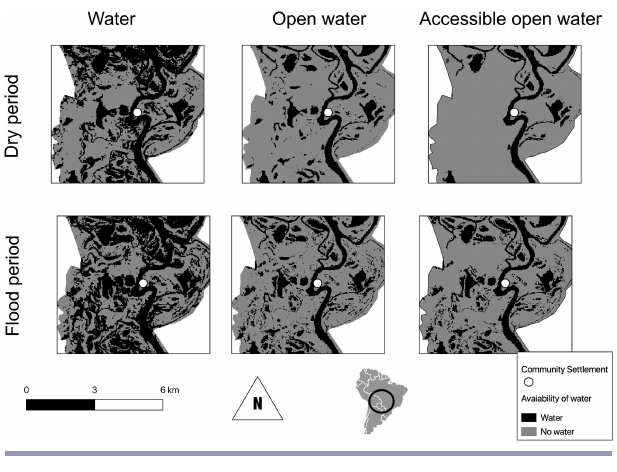
Fig. 2 . Seasonal variation in accessible water for fishing in the Pantanal. The first row refers to the images from the dry period (“water”: all water in the system; “open water”: all water that is not covered by aquatic vegetation; and “accessible open water”: all water bodies that are not covered by aquatic vegetation and can be accessed by boat from the main river. The second row refers to the images from the flood period, also showing the three “water” types.